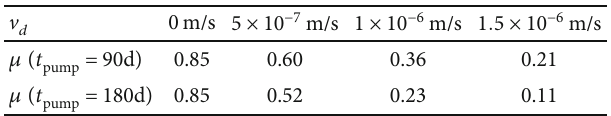
Table 2: The recovery ratio μ of contaminant at the end of pumping phase.